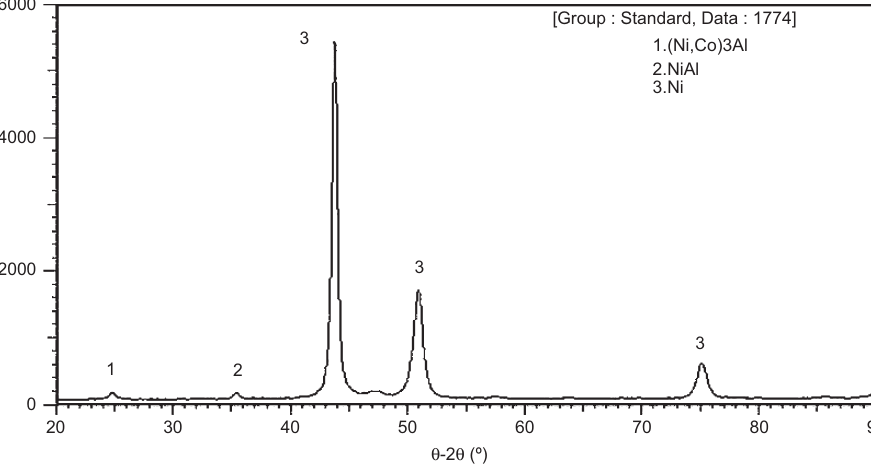
Figure 3 X-ray diffraction (XRD) results from Ni+Al+15% Co